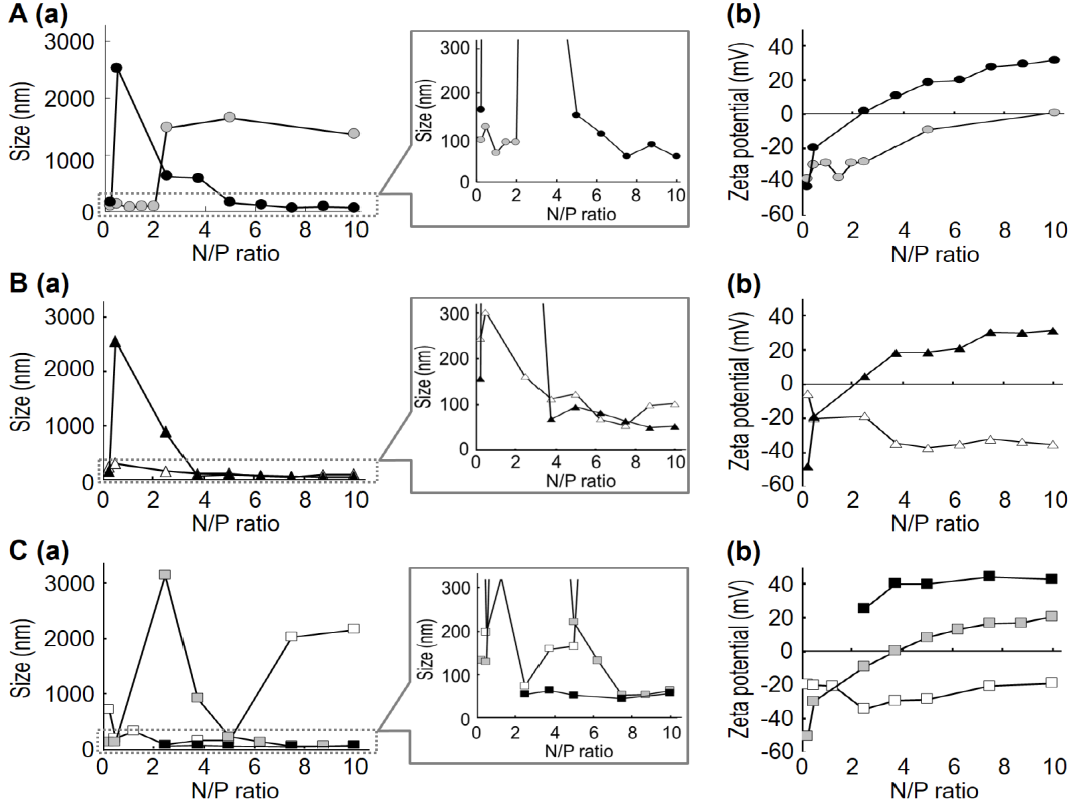
Figure 1. Relationship between the N/P ratio and diameter or zeta-potential of siRNA/MCD nanoparticles prepared using various MCDs. In this experiment, siRNA targeting GFP was used for preparing the nanoparticles. ( A ): the diameters ( a ) and zeta-potentials ( b ) of siRNA/MCD nanoparticles formed using Type-C in a series of N/P ratios: gray circles, C-1; closed circles, C-2; ( B ): the diameters ( a ) and zeta-potentials ( b ) of siRNA/MCD nanoparticles formed using Type-D at a series of N/P ratios: open triangles, D-1; closed triangles, D-2; ( C ): the diameters ( a ) and zeta-potentials ( b ) of siRNA/MCD nanoparticles formed using Type-E in a series of N/P ratios: open squares, E-1; gray squares, E-2; closed squares, E-3. Data are the means (n =